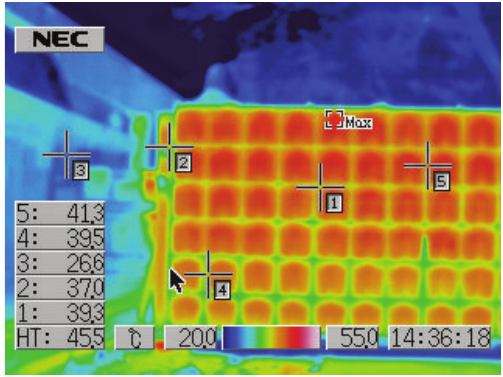
Figure 13: Temperature distribution of the BIPV